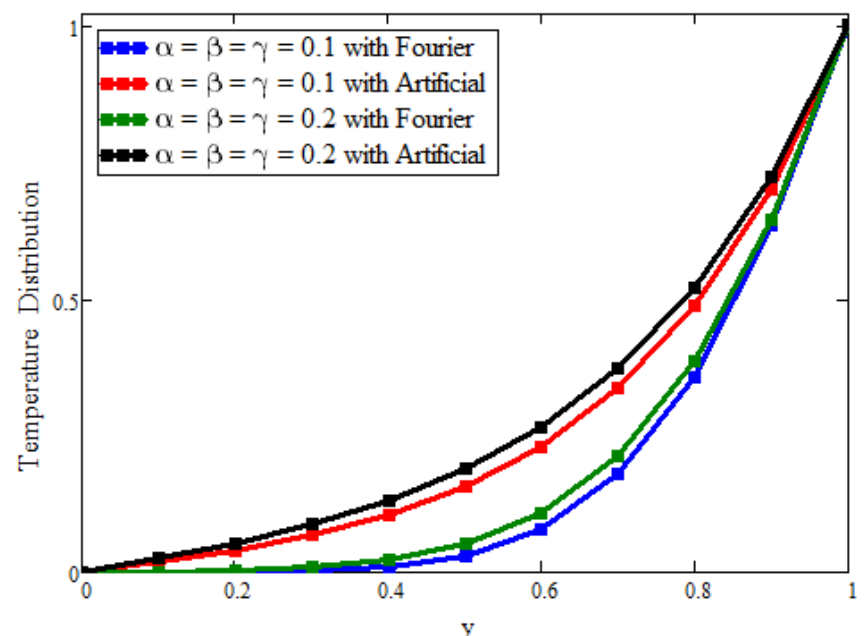
Figure 4. The effects of fractional parameters on the temperature field. Here, a = 0.02, t = 0.4, Pr = 21, φ 1 = 0.01, φ 2 = 0.02, and φ 3 =